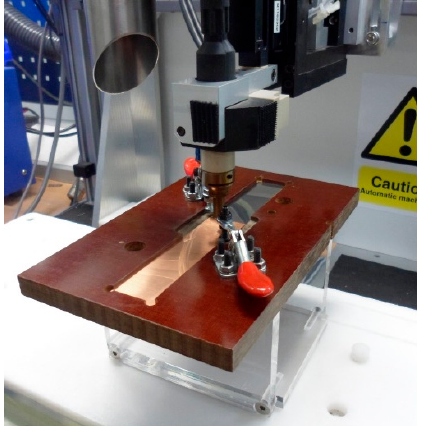
all operations and a new electrode was used for each set of coupons.